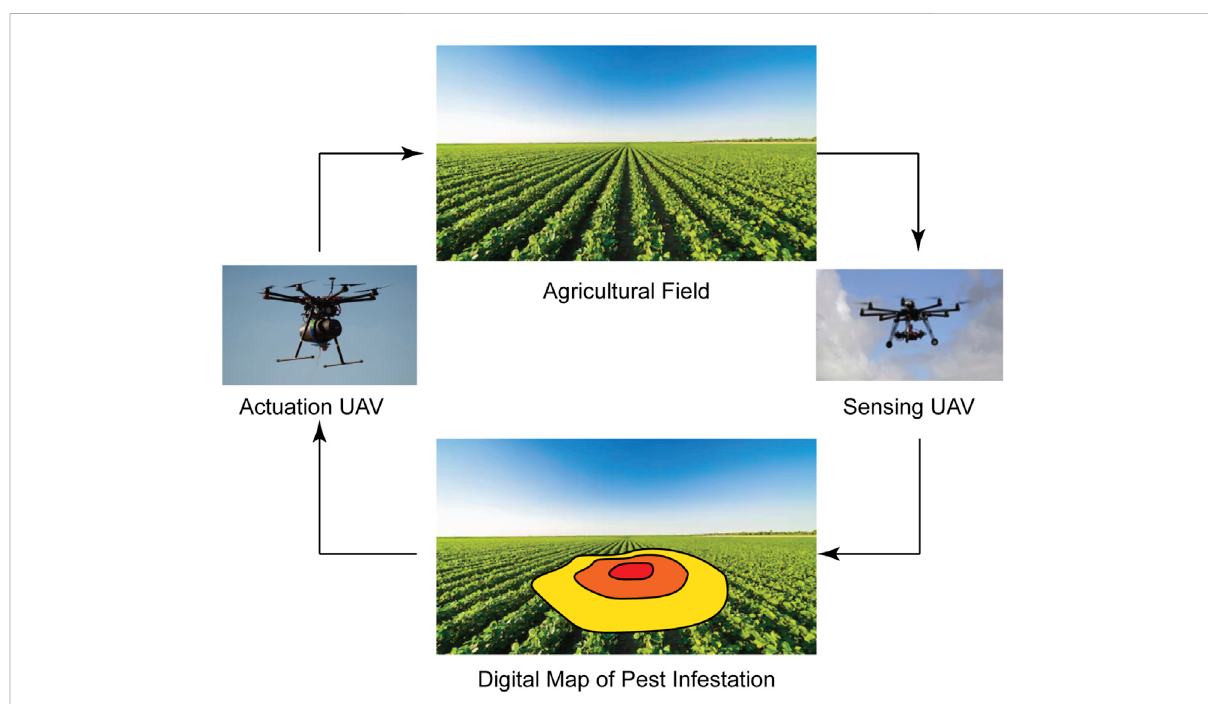
FIGURE 1 Our envisioned closed-loop UAV-based precision pest management system. This system features two types of UAVs (Teske et al., 2019; Iost Filho et al., 2020): (1) sensing UAVs to scan the fi eld and identify infested plants (Nansen et al., 2019, 2021) and (2) actuation UAVs to precisely and autonomously deliver persimilis to the infested